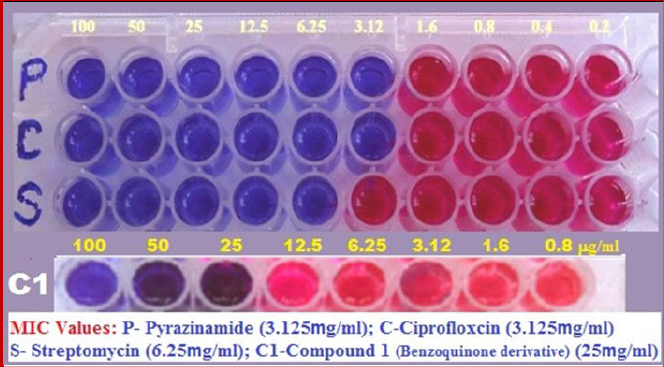
Figure 2: Antimycobacterial potential of endophytic fungal metabolite C1 from D.